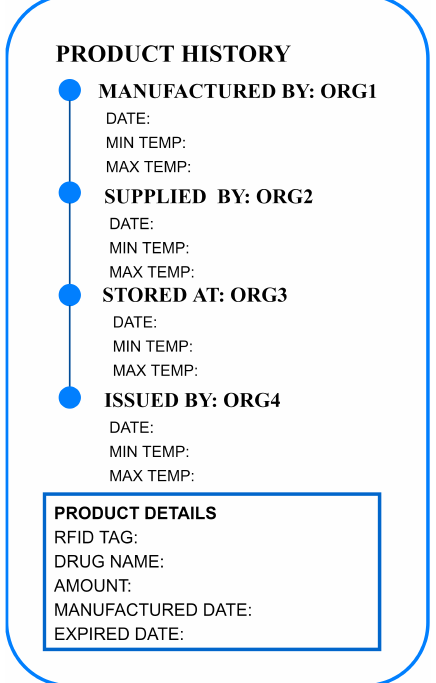
Figure 6. User output of product history at the end of transferring a batch through the supply